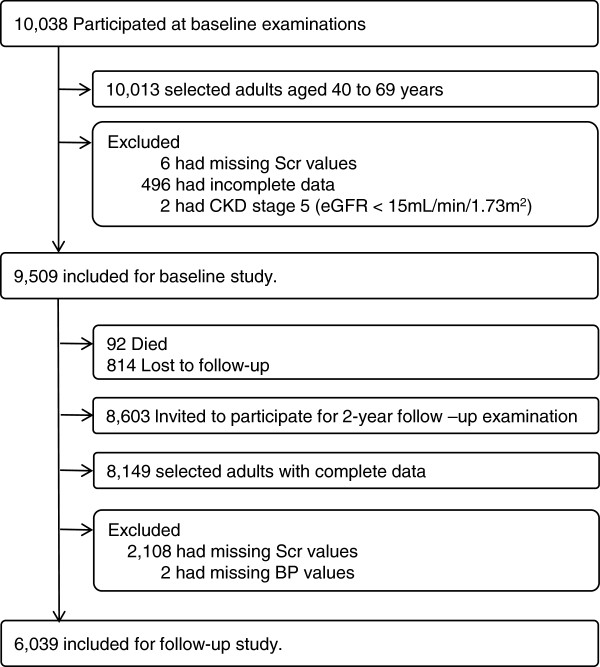
Study participants at baseline and follow-up examinations.